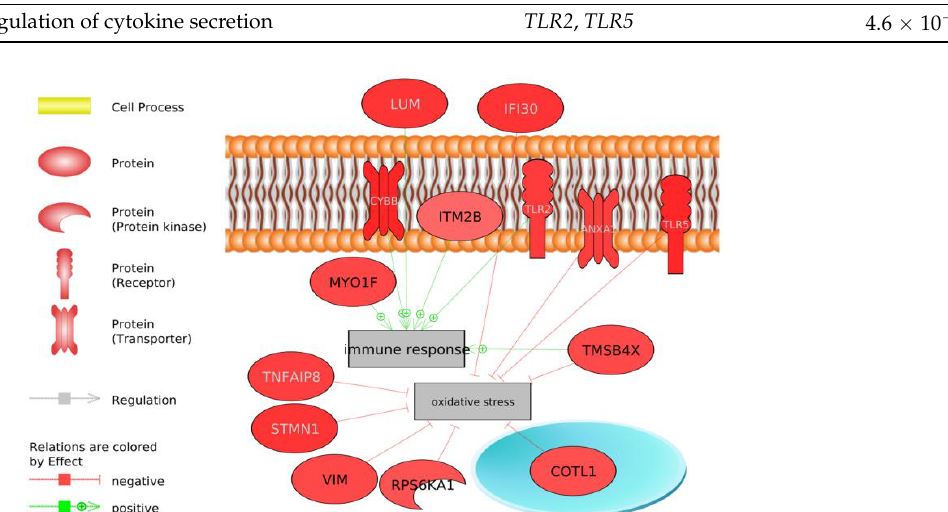
Figure 3. DEGs involved in the immune response and oxidative stress identified using Pathway Studio software. Highlighted in red are genes over-expressed in the LRFI group and in blue are under-expressed genes in the LRFI group. Green arrows indicate a positive regulation effect, while red arrows indicate a negative regulation effect.